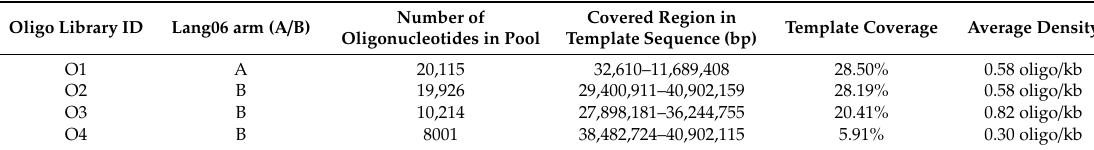
Table 2. Characteristic of the designed